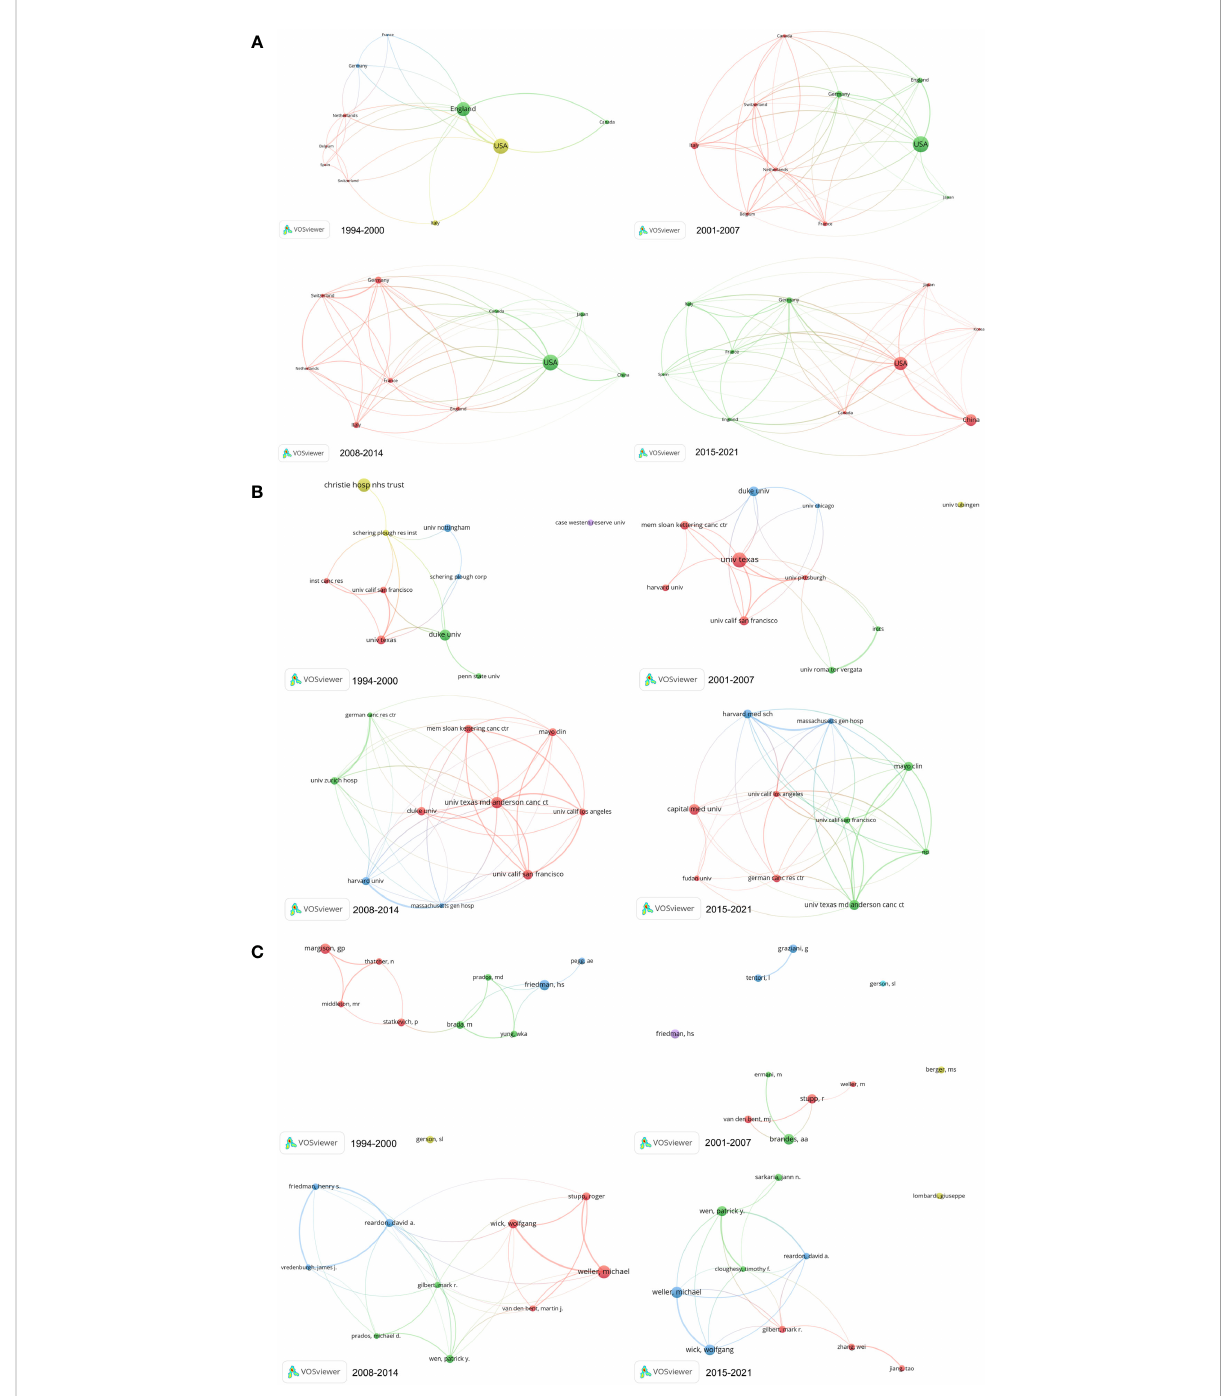
FIGURE 6 The evolution of collaborative networks among different research forces. (A) The evolution of collaboration networks of top 10 proli fi c countries. (B) The evolution of collaboration networks of top 10 proli fi c institutions. (C) The evolution of collaboration networks of top 10 proli fi c authors. From: CiteSpace, VOSviewer doi: